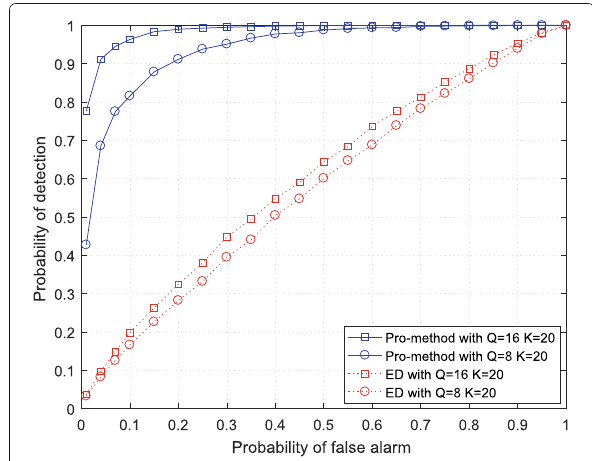
Fig. 5 ROC curves of the proposed method and ED with different sampling numbers at SNR = − 15 dB